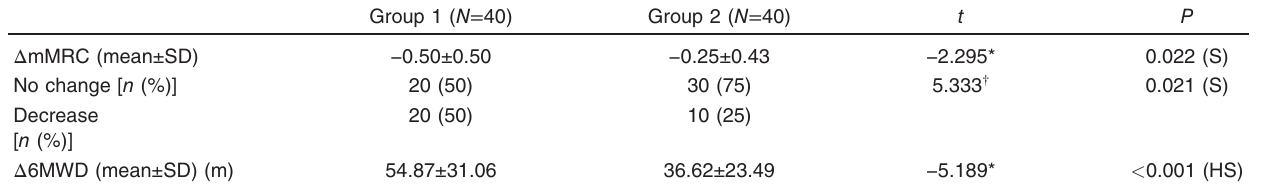
Table 5 Comparison between group 1 and group 2 regarding post-treatment change in modified-Medical Research Council and 6min walk distance